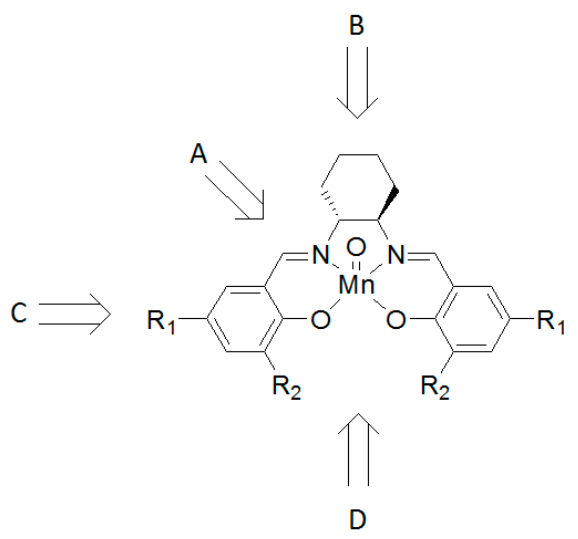
Figure 1. Proposed directions of approach to the active Mn-oxo moiety of (salen)Mn.